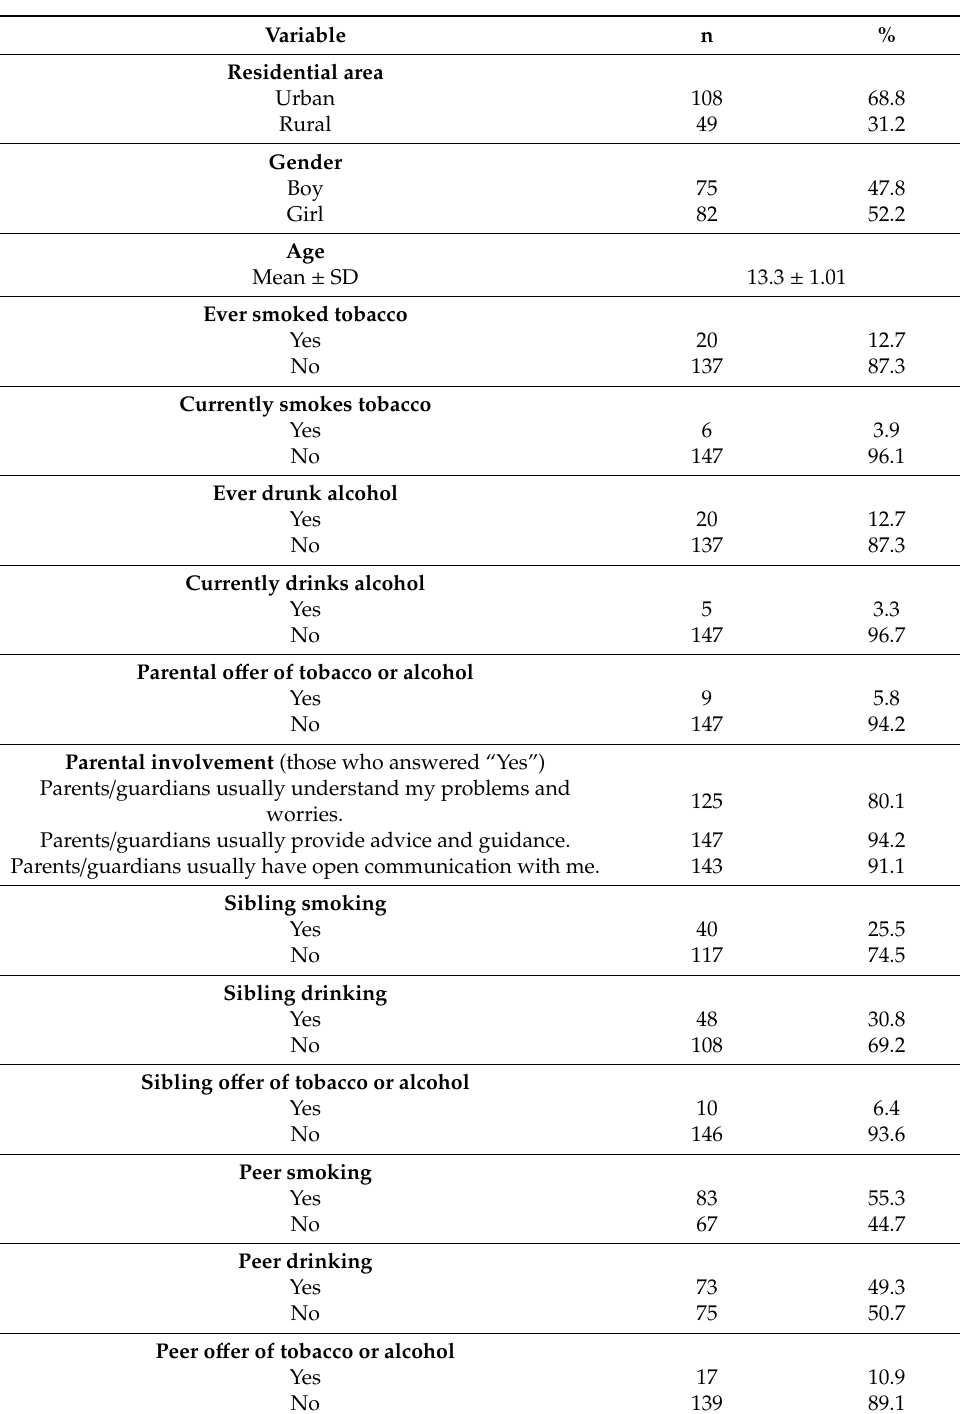
Table 1. Characteristics of the sample of adolescents (n =